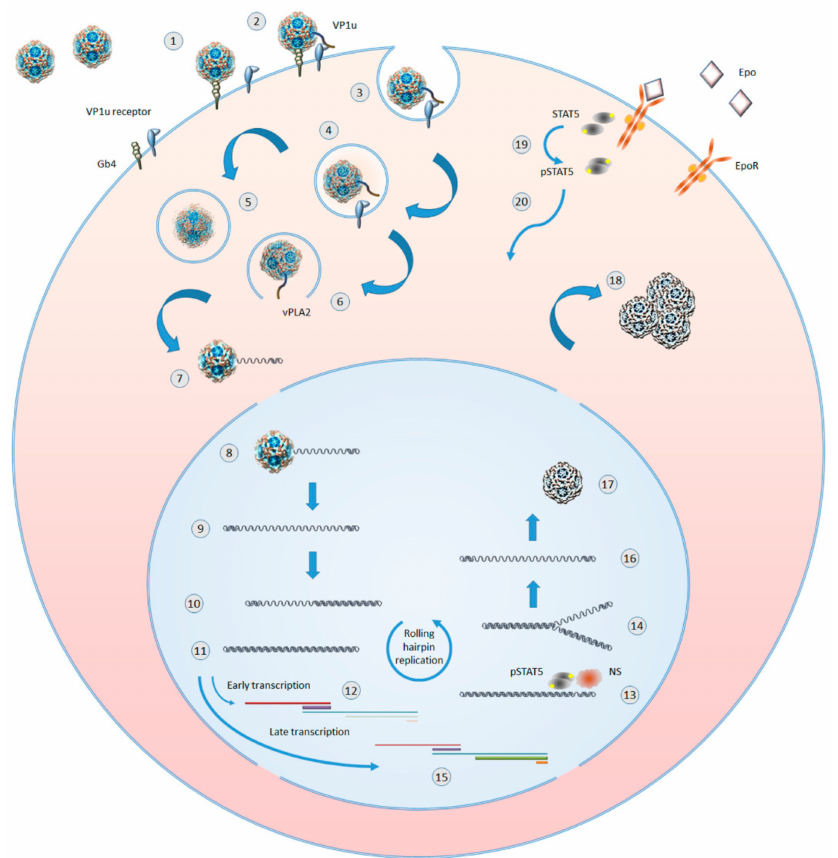
Figure 2. Outline of B19V replicative cycle in erythroid progenitor cells. 1: virion binding to globoside. 2: extrusion of VP1 unique (VP1u) region and binding to an erythroid specific receptor. 3: clathrin-mediated endocytosis. 4: virions in endosomal vesicles. 5: virion processing within endosomes. 6: VP1u-associated viral phospholipase (vPLA2) mediated virion escape from endosomes.